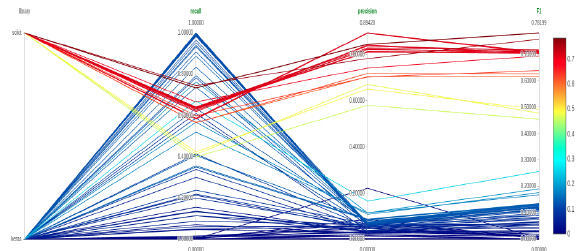
Figure 11 . Comparison of experiments according to different metrics (recall, precision, F1-score) with MLFlow. Each line represents an experiment.